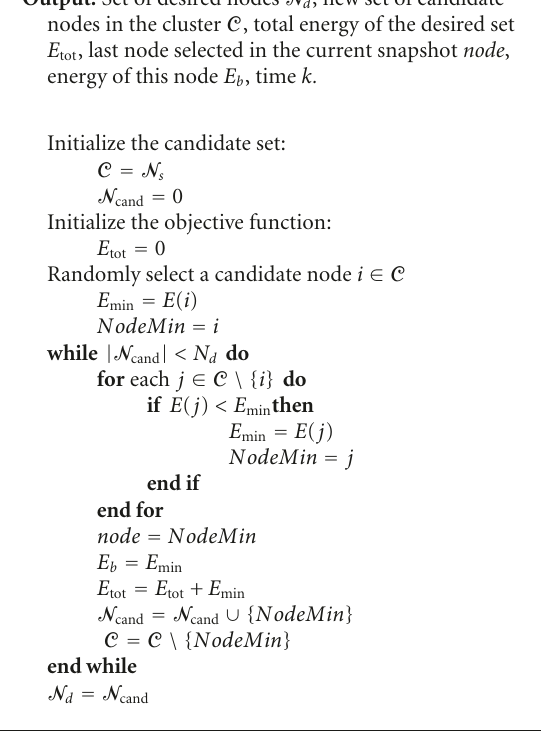
Algorithm 1: Greedy random node selection.